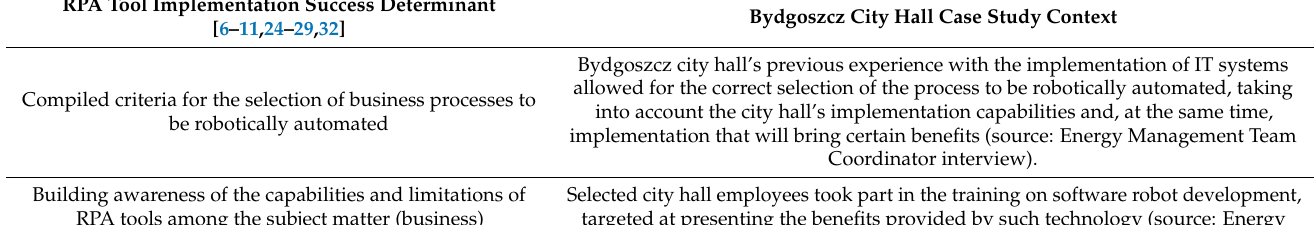
Table 2. A list of the RPA tool’s implementation success determinants in the context of the Bydgoszcz city hall case study. RPA Tool Implementation Success Determinant